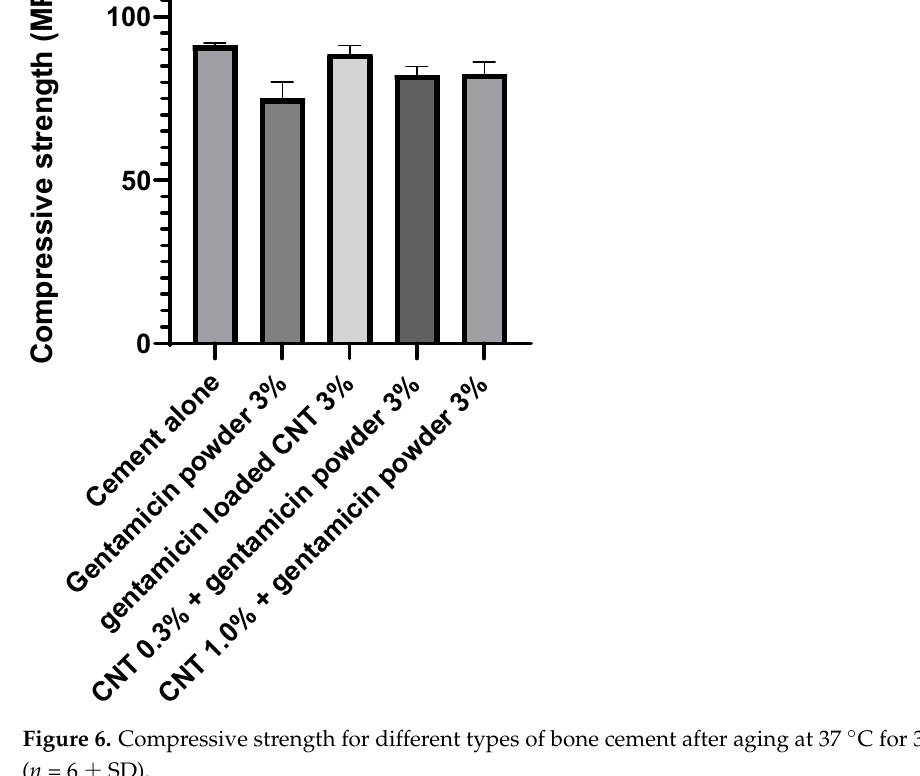
Figure 7. Water uptake for different bone cements after incubation in pH 7.4 PBS buffer ( n = 3 ± SD).